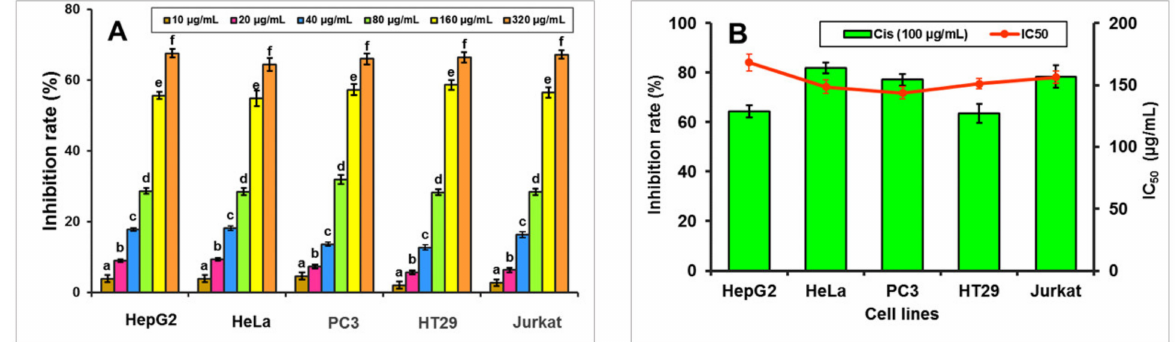
Figure 6. Anti-tumour activity of CICP on different human cell lines ( A ); IC 50 values ( B ). Mean values within each cell line with different letters (a–f) show significant differences ( p < 0.05) between